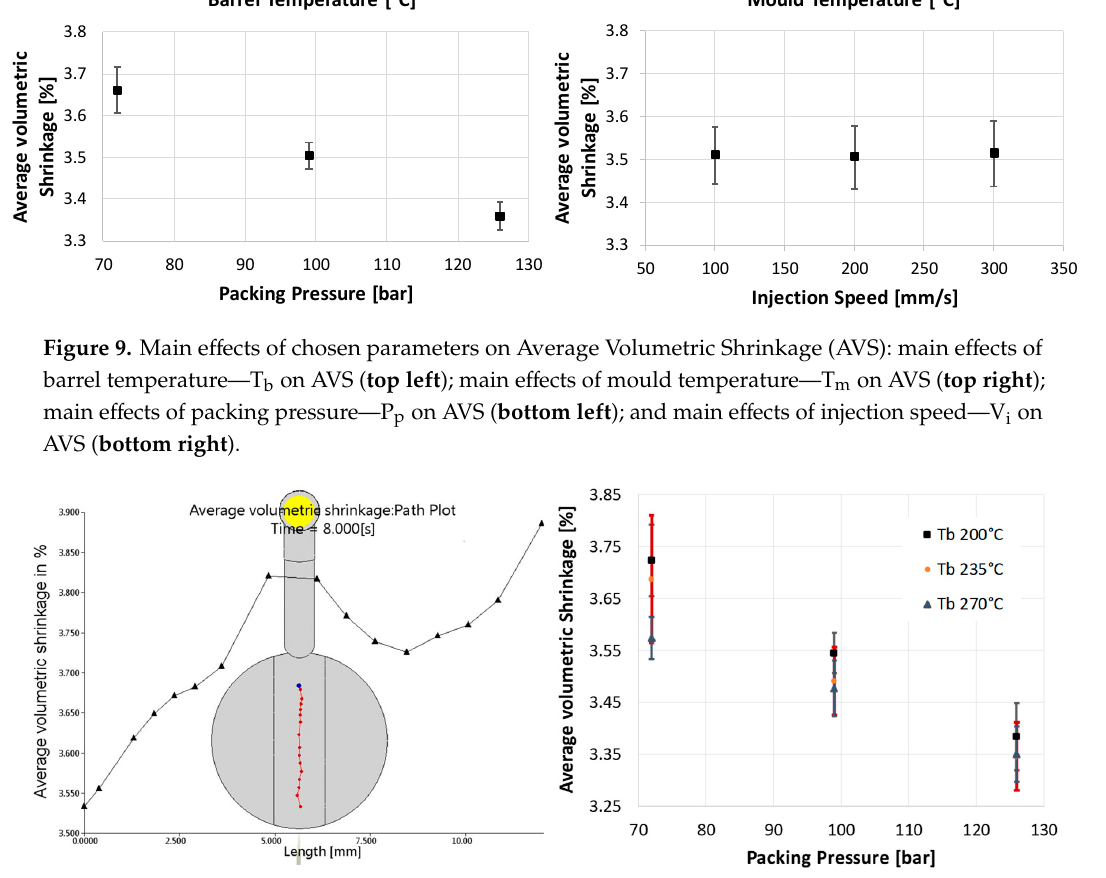
Figure 10. Average volumetric shrinkage path plot along the middle of the part ( left ), Two-factor interaction of T b and P p for “Average volumetric shrinkage” ( right ).